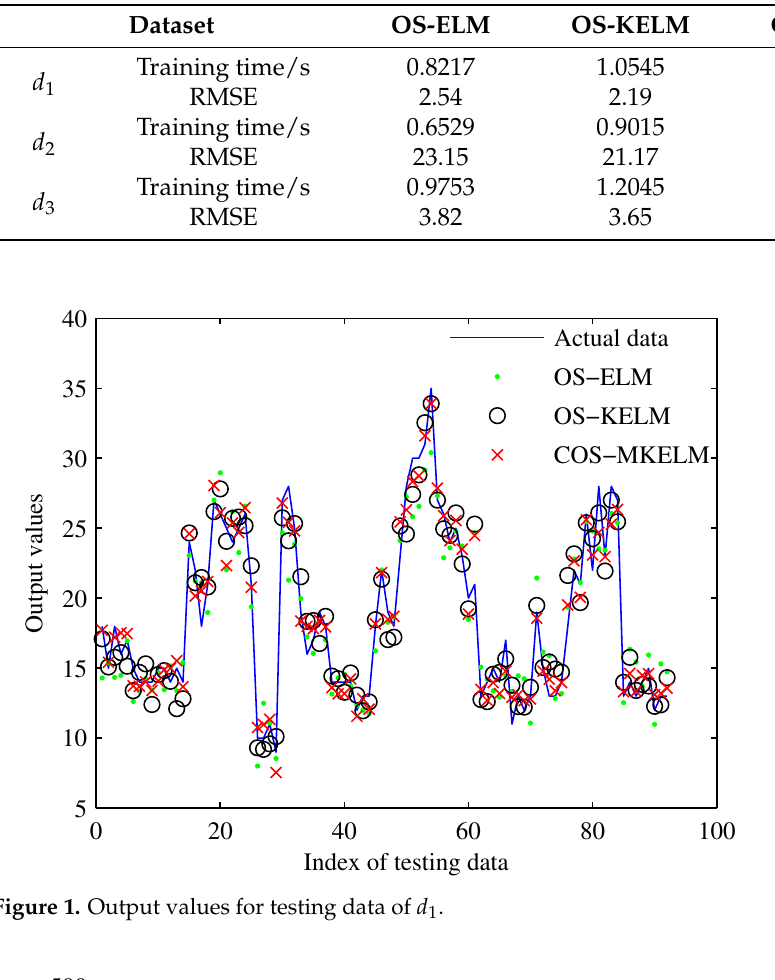
Figure 1. Output values for testing data of d 1 .